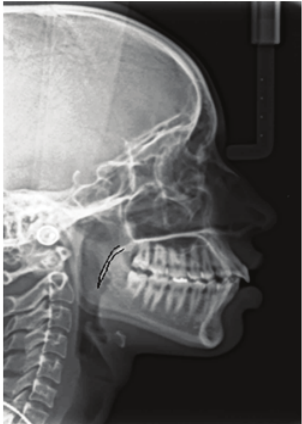
Figure 2: Rat-tail shape seen on lateral cephalogram.